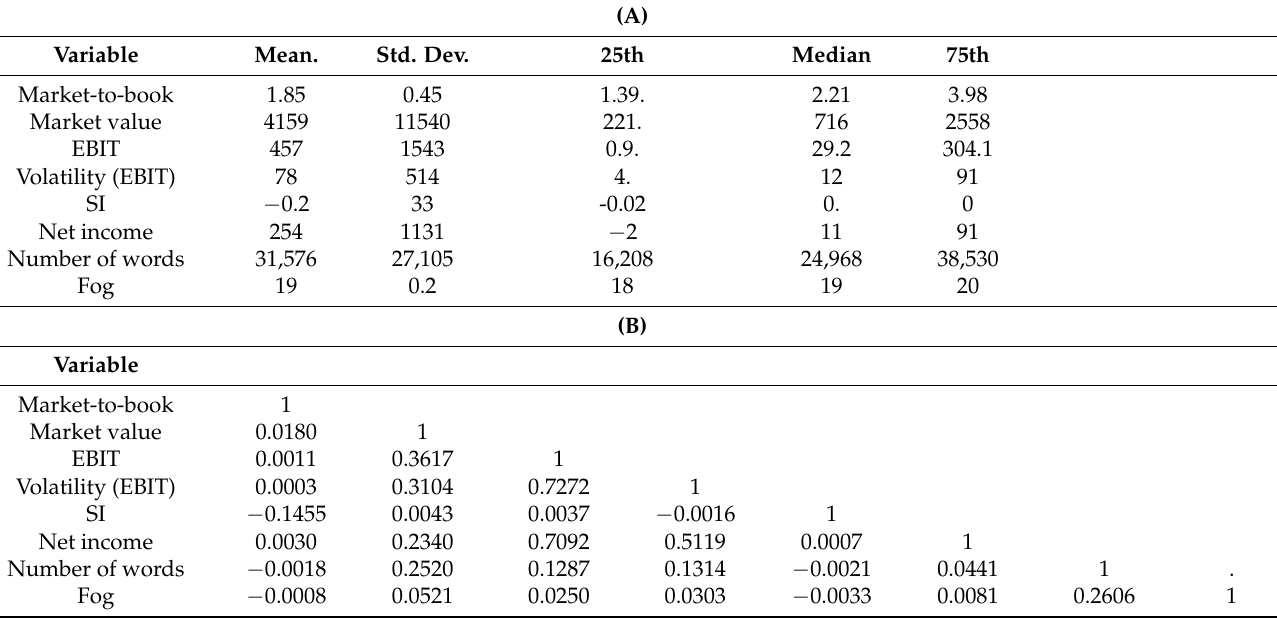
Table 1. ( A ) Descriptive statistics. ( B ) Pearson correlation